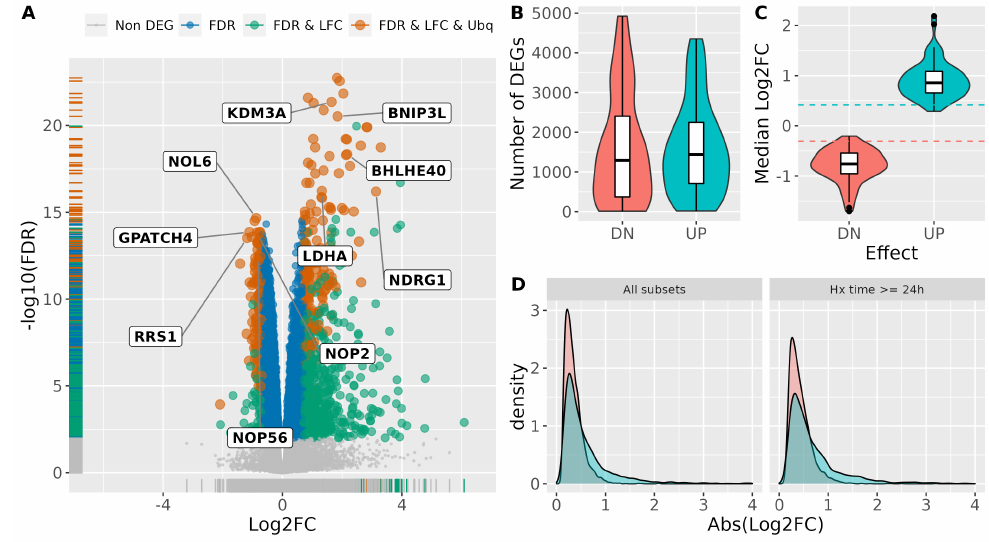
Figure 3. Identification of a common set of hypoxia-regulated genes. ( A ) The graph represents the pooled effect of hypoxia on gene expression (Log 2 FC hypoxia over normoxia) against the statistical significance of the effect ( − log 10 FDR − adjusted p − value) according to the meta-analysis. Genes are represented as dots and their color indicates the effect of hypoxia: grey, genes not regulated by hypoxia ( FDR − adjusted p − value ≥ 0.01); blue, genes mildly affected by hypoxia ( FDR − adjusted p − value < 0.01 and | Log 2 FC | ≤ 0.7); green, genes strongly regulated by hypoxia ( FDR − adjusted p − value < 0.01 and | Log 2 FC | > 0.7), and dark red, ubiquitous genes regulated by hypoxia (strongly regulated genes present in > 90% of the subsets). Non significant genes are represented by smaller dots to avoid saturation. ( B ) Distribution of the number of genes found significantly ( FDR − adjusted p − value ≥ 0.01) down- (“DN”) or up-regulated (“UP”) by hypoxia in individual studies. ( C ) Distri- bution of the median effect size (Log 2 FC Hypoxia over Normoxia) of hypoxia on repressed (“DN”) or induced (“UP”) genes in individual studies. The red and blue dotted lines correspond to the median effect size for repressed and induced genes respectively, according to the meta-analysis pooled esti- mates. ( D ) Distribution of Log 2 FC values for significantly down-regulated (blue) and up-regulated (red) genes, both in a meta-analysis including all the subsets, as well as in a meta-analysis restricted to subsets corresponding to hypoxia treatments of 24 h or